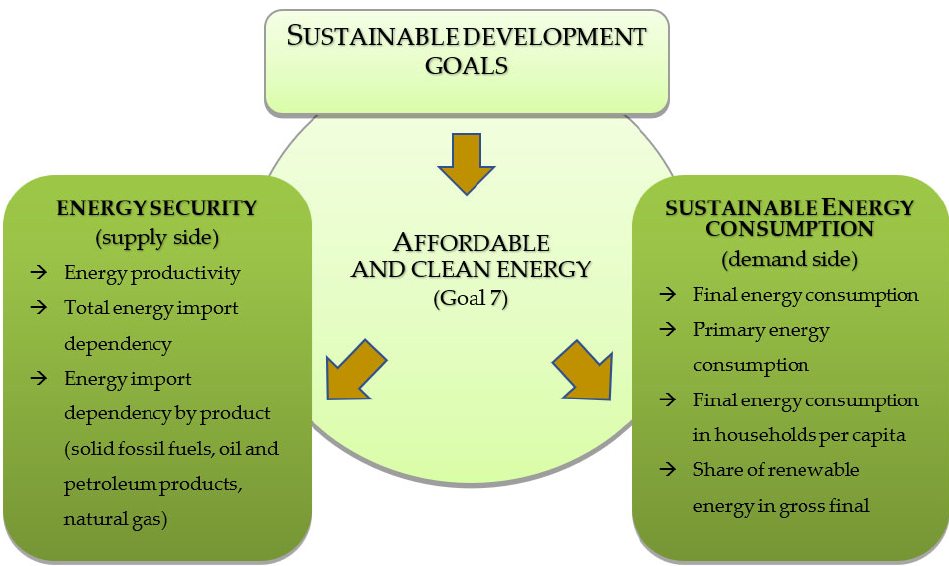
Figure 1. Indicators for Sustainable Development Goal 7.